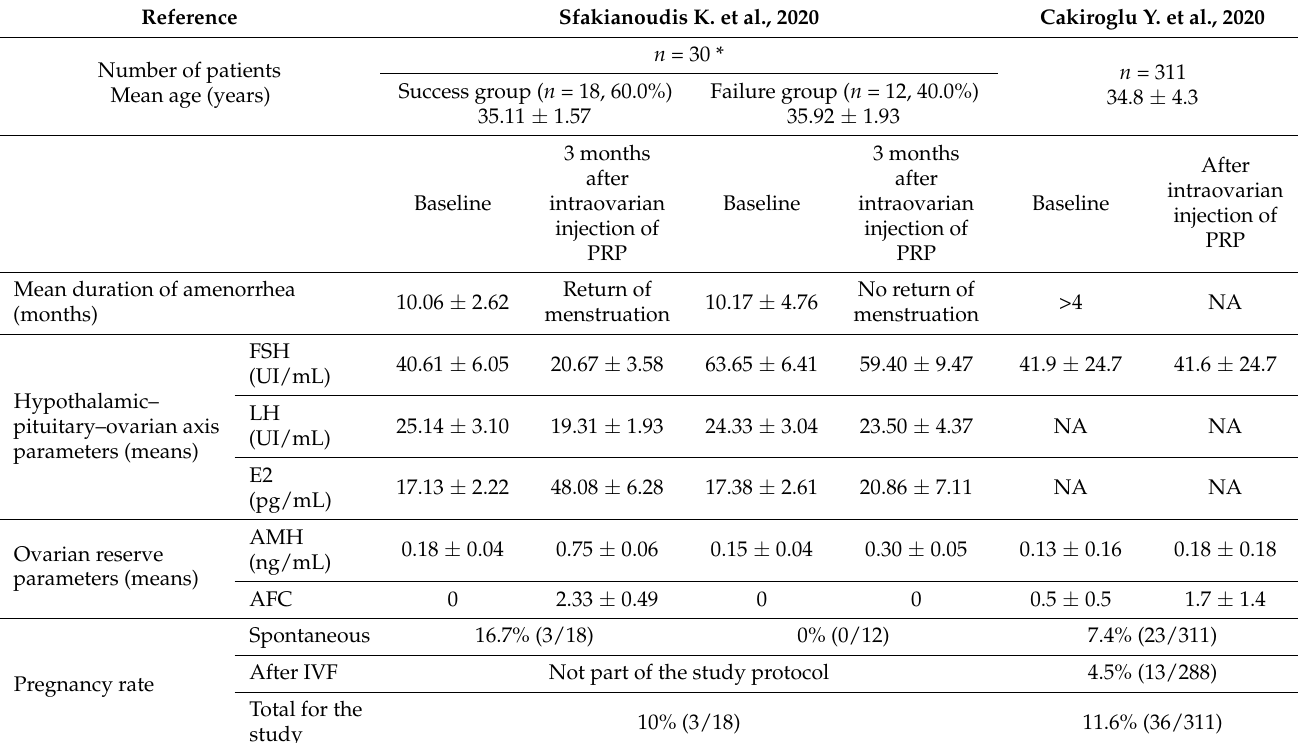
Table 1. Clinical studies conducted with intraovarian injection of autologous platelet-rich plasma to restore fertility in women suffering from spontaneous premature ovarian